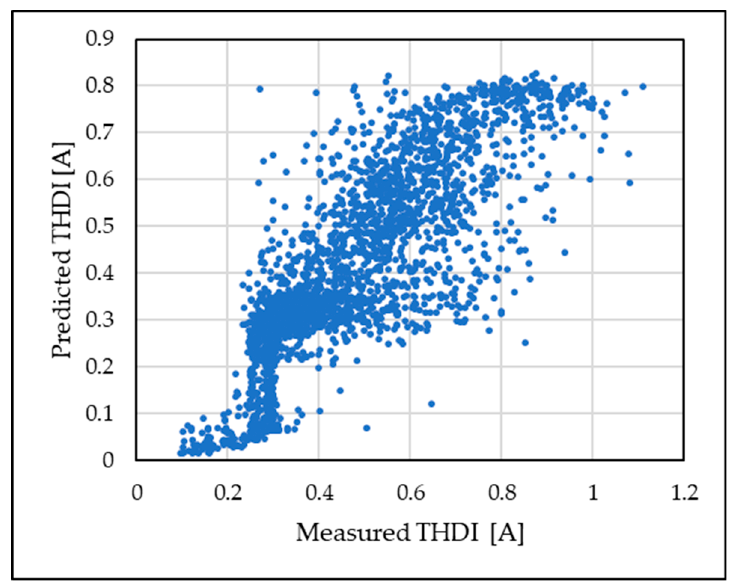
Figure 16. Scatterplot of the measured and predicted THDI by the MLPNN 6 model.